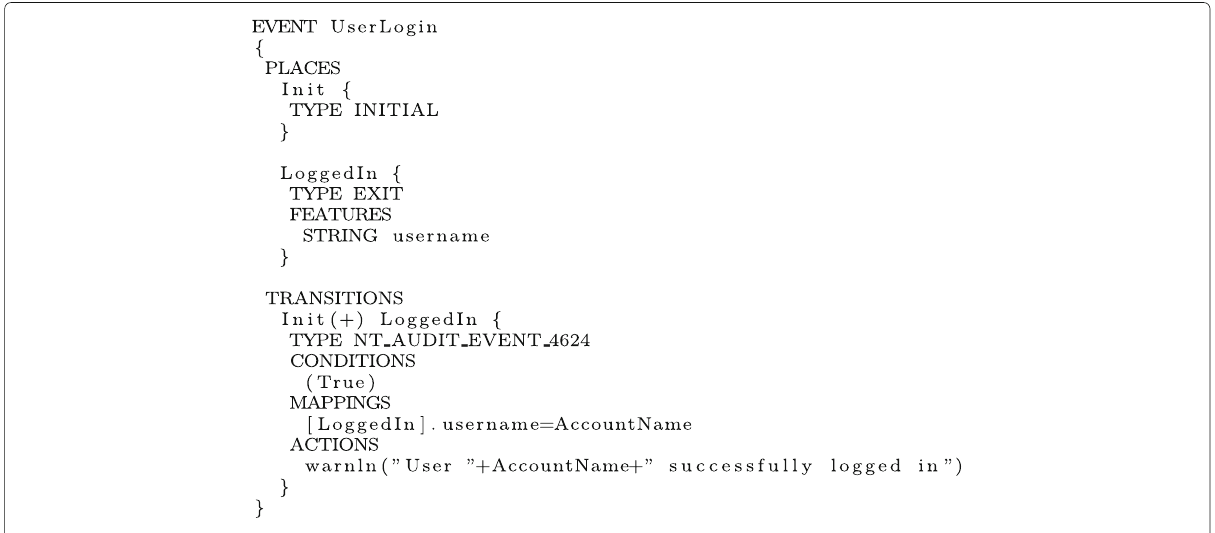
Fig. 2 Example of an EDL signature called UserLogin for a simple login onto a Windows system, by Jaeger et al.